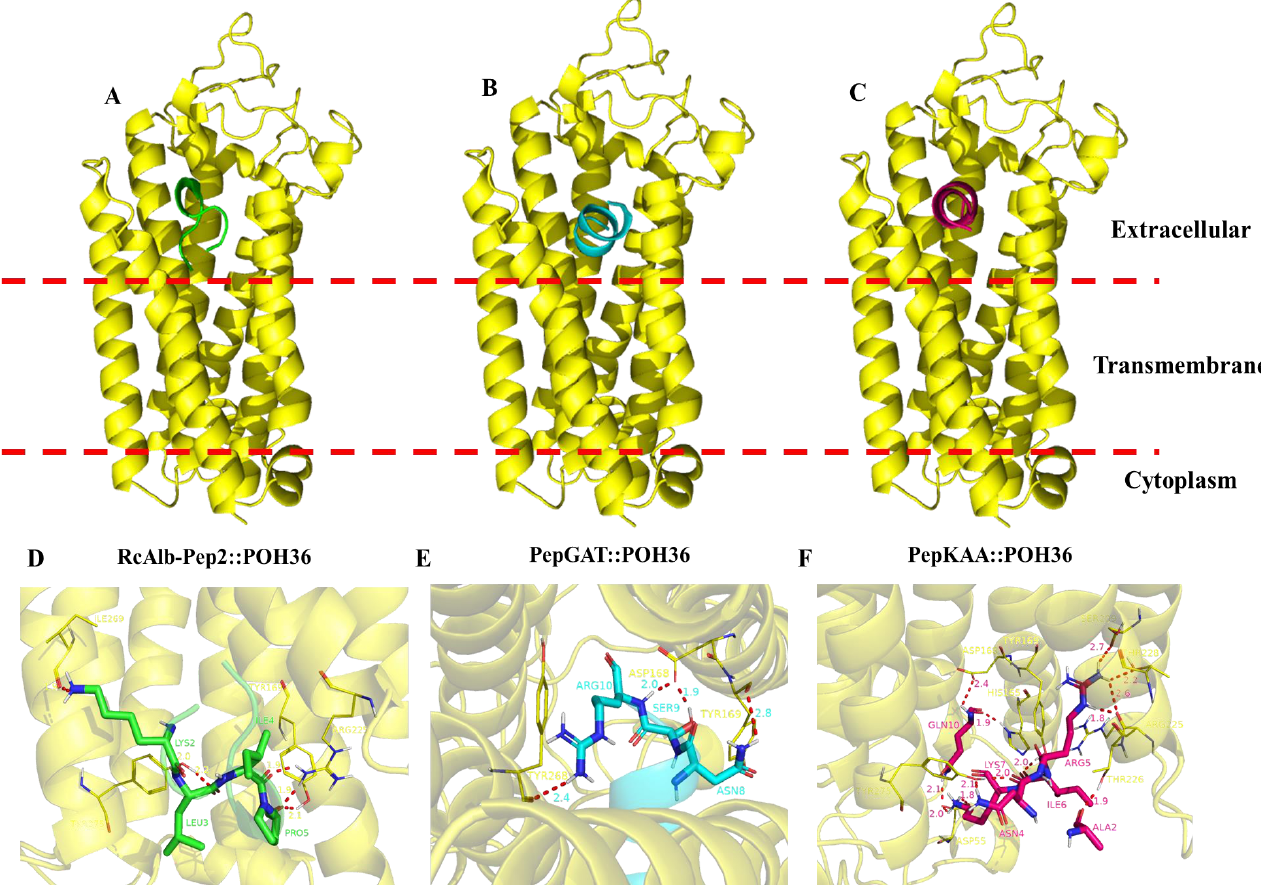
Figure 7. Molecular docking analysis of synthetic peptides and PHO36 receptor from C. neofor- mans . Overview of the interaction of peptides ( A ) RcAlb-PepII, ( B ) PepGAT, and ( C ) PepKAA with PHO36 from C. neoformans. Zoomed view of peptides ( D ) RcAlb-PepII, ( E ) PepGAT, and ( F ) PepKAA with PHO36 from C. neoformans showing amino acid residues involved in the interaction and distance.